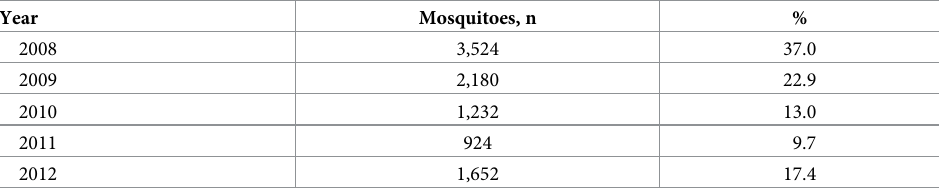
Table 1. Total number of Anopheles sinensis collected by black light traps at 12 sites in Goyang, Korea, during the period from 23 to 43 weeks in 2008–2012 (n =